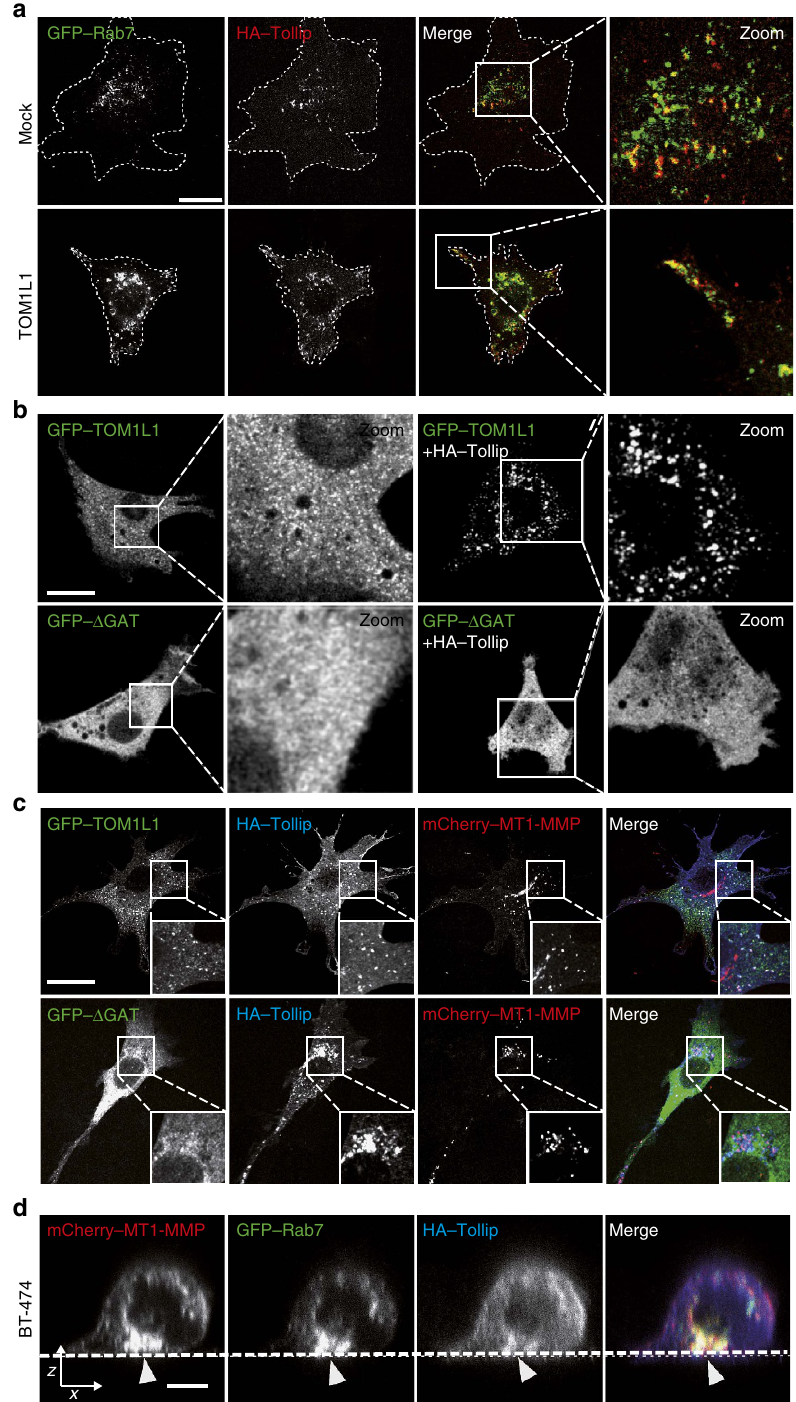
Figure 7 | TOM1L1 is recruited by TOLLIP to RAB-7/MT1-MMP endosomes for MT1-MMP trafficking. ( a ) Co-localization of TOLLIP and RAB-7. About 48h after GFP–RAB-7 and HA–TOLLIP transfection, 3T3-neu cells infected with viruses expressing the indicated constructs were seeded on gelatin-coated coverslips for 3h and immunolabelled using an anti-HA antibody. ‘Zoom’ panels show higher magnification of the boxed areas. Note the relocalization of TOLLIP/RAB-7 co-localization at the cell periphery when TOM1L1 is expressed. Scale bar, 20 m m. ( b ) Endosomal TOM1L1 recruitment by TOLLIP. 3T3-neu cells were transfected with GFP–TOM1L1 or GFP– D GATalone or with HA–TOLLIP. About 48h after transfection cells were seeded on gelatin-coated glass bottom dishes to visualize TOM1L1 localization. ‘Zoom‘ panels show higher magnification of the boxed areas. Scale bar, 20 m m. ( c ) Endosomal co-localization of TOM1L1, TOLLIP and MT1-MMP. About 48h after GFP–TOM1L1/ D GAT, HA–TOLLIP and mCherry MT1-MMP transfection, 3T3-neu cells were plated on gelatin-coated coverslips for 3h then immunolabelled with an anti-HA antibody to visualize co-localization. Insets show higher magnification of the boxed areas. Scale bar, 20 m m. ( d ) Co-localization of MT1-MMP, RAB-7 and TOLLIP in BT-474 cells. BT-474 cells were transfected with mCherry–MT1-MMP, GFP–Rab-7 and HA–TOLLIP. About 48h after transfection, cells were plated on gelatin-coated coverslips and imaged by confocal orthogonal ( x/z ) imaging. Note the basal co-localization of mCherry–MT1-MMP, GFP–RAB-7 and HA–TOLLIP (arrowheads). Scale bar, 10 m